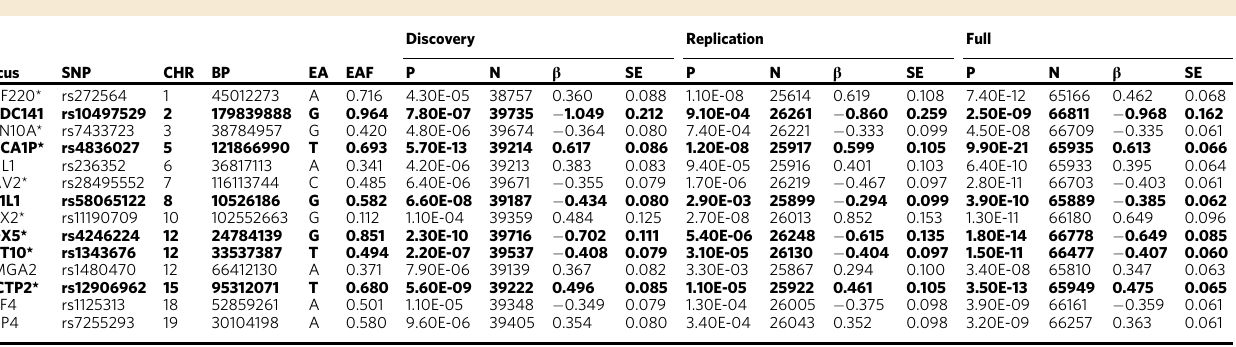
Table 1 Loci associated with HR response to exercise